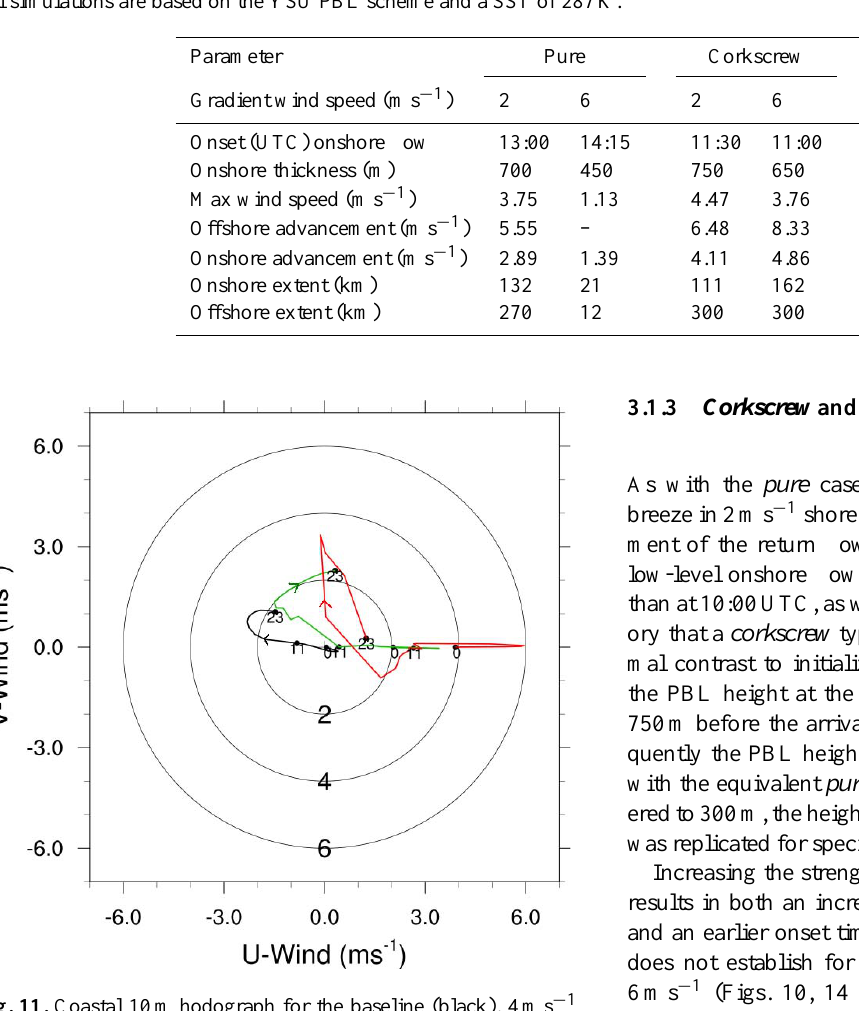
Fig. 11. Coastal 10m hodograph for the baseline (black), 4ms − 1 (green) and 8ms − 1 (red) offshore gradient winds. Numbers indi- cate the simulation hour in UTC and concentric circles indicate the magnitude of the 10m wind speed vector. The u-wind component is positive in the offshore direction and the v-wind is positive in the shore-parallel direction with the land mass to the left. In each sim- ulation, the PBL scheme was YSU and the SST was set to 287K. A single coastline was also used in all